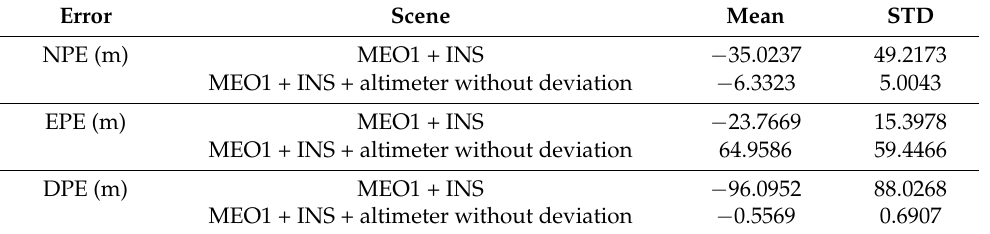
Table 8. Position error statistics.